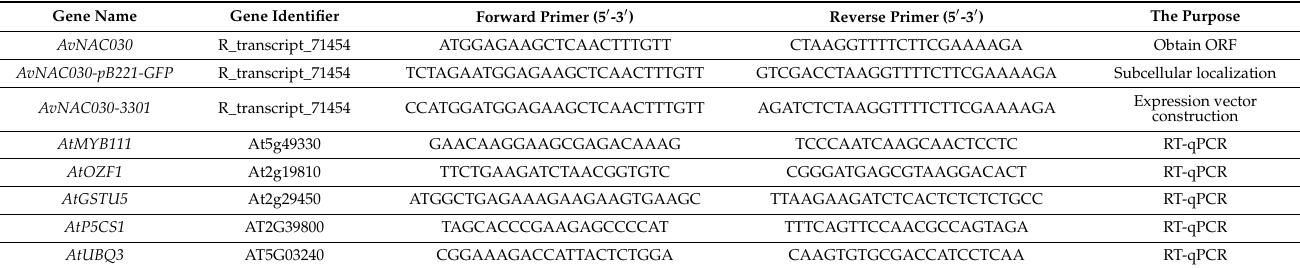
Table 4. List of primers used for RT-qPCR and the construction of recombinant